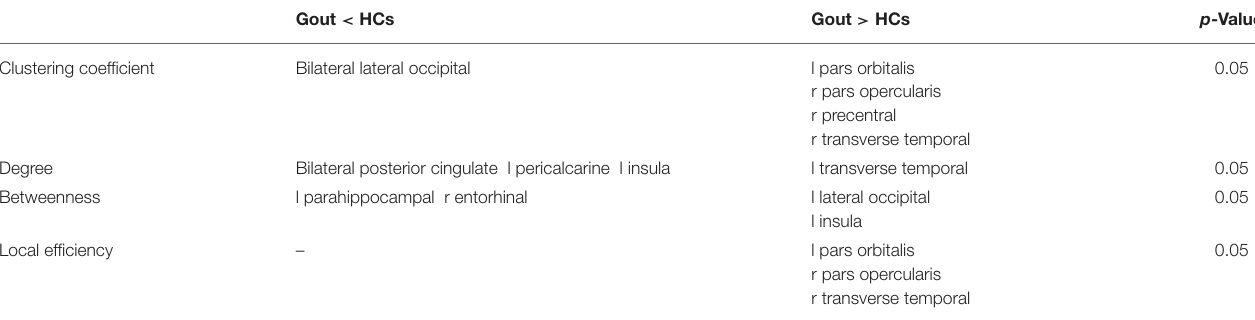
TABLE 2 | Between-group differences in regional network